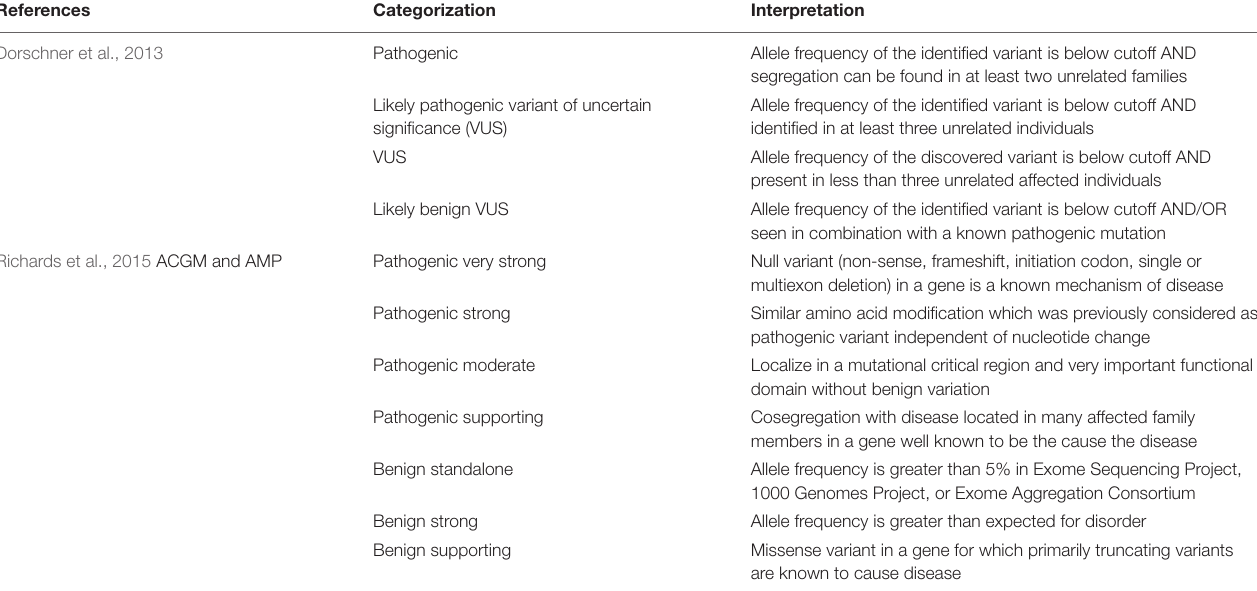
TABLE 2 | Variants pathogenicity